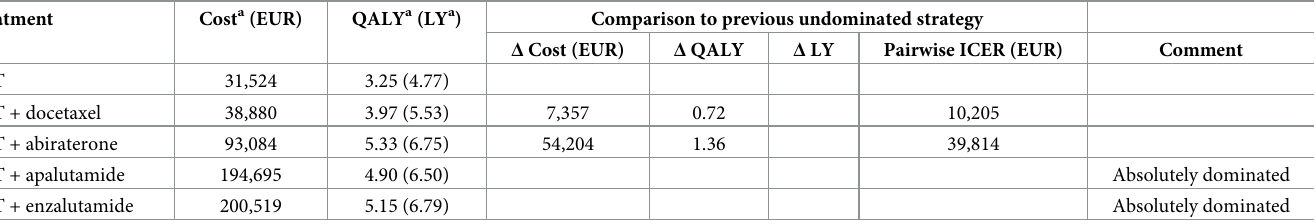
Table 2. Results of the base case (per person).